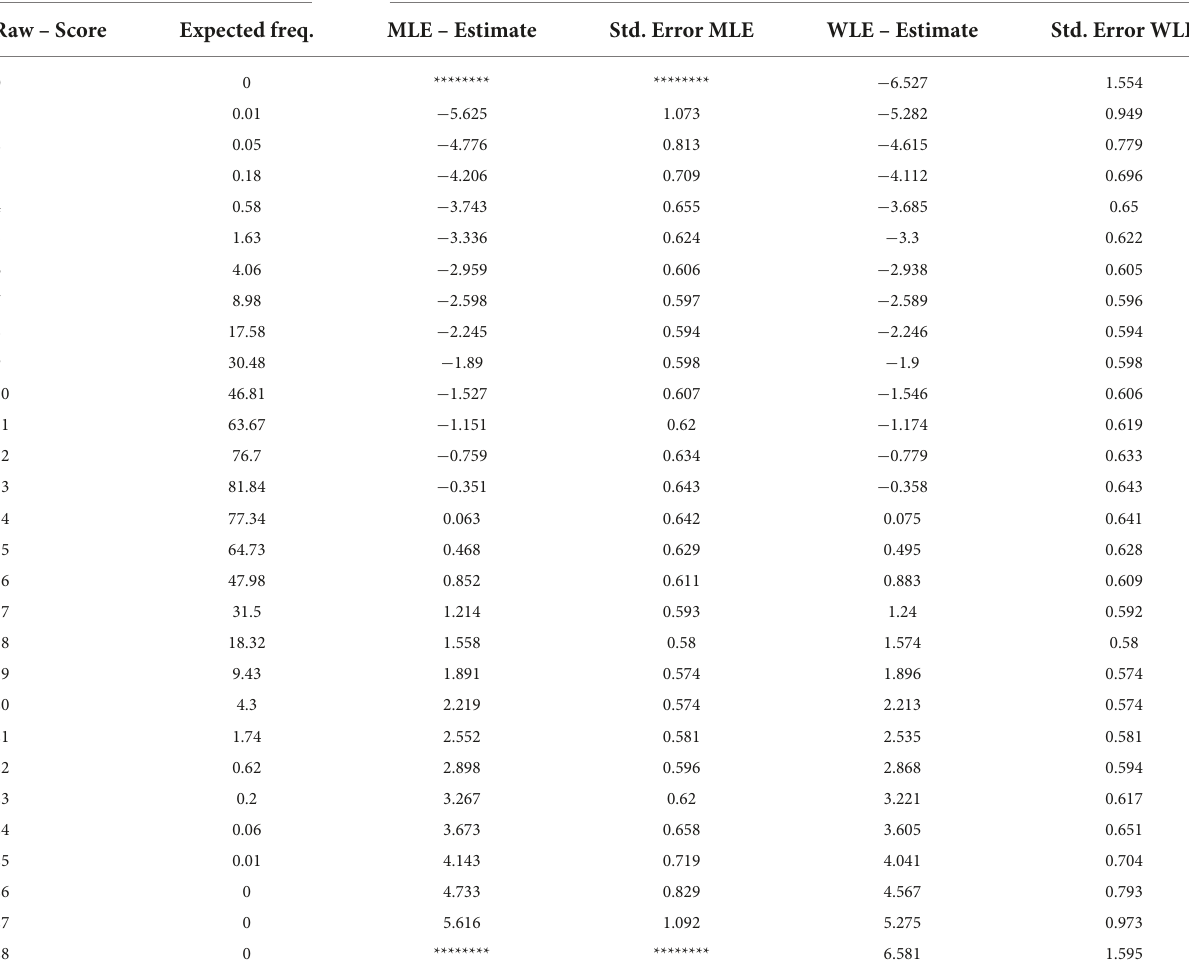
TABLE 3 Person Parameters: CLASS 1 of 3 with size 0.41231 – Partial Credit Model. Score frequency Person parameters and standard errors: